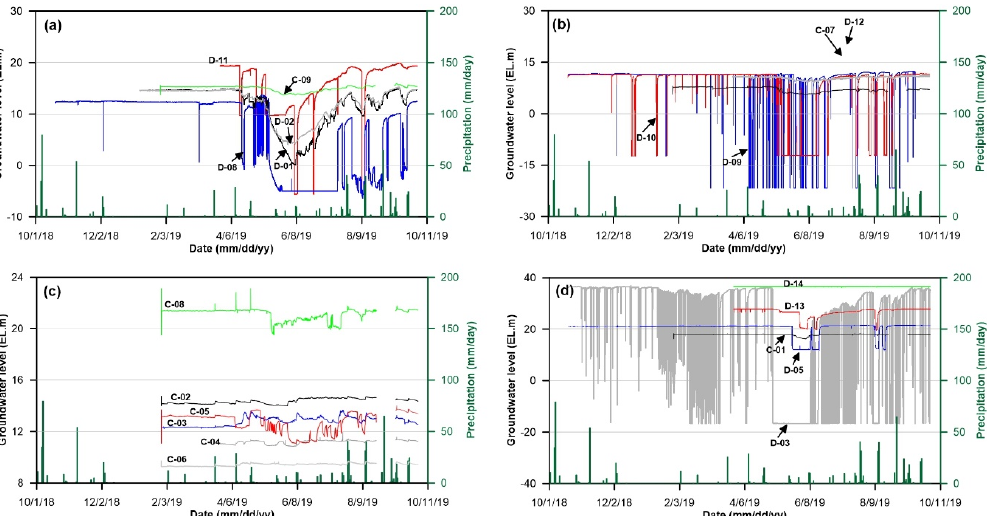
Figure 2. Groundwater level fluctuations of ( a ) pumping wells D-08 and D-11, and monitoring wells D-01, D-02, and C-09; ( b ) pumping wells D-09 and D-10, and monitoring wells D-12 and C-07; ( c ) monitoring wells C-02, C-03, C-04, C-05, C-06, and C-08; ( d ) pumping wells D-03, D-05, and D-13, and monitoring wells D-14 and C-01. Groundwater levels expressed as the altitude above mean sea level.